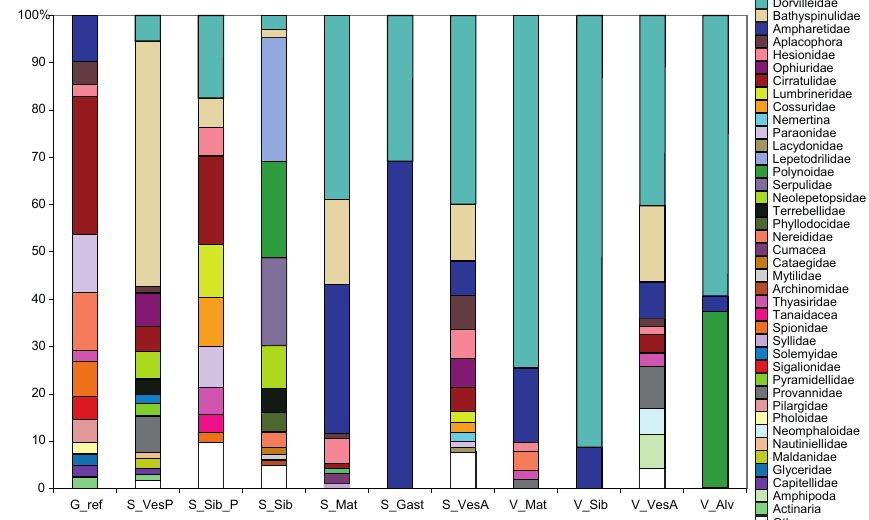
Figure 7. Histograms of relative macrofaunal compositions at the family level in assemblages shown for each study site; only taxa contribut- ing to more than 1% are shown.